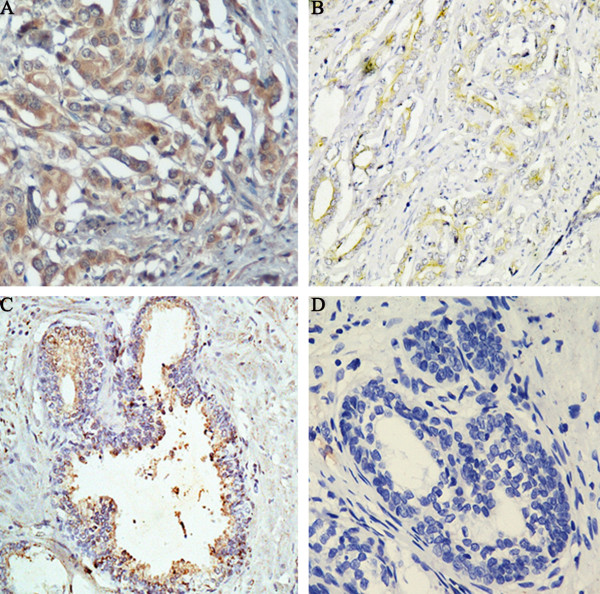
Immunohistochemical staining for NUCB2 in PCa and benign prostate tissue (original magnification ×200). (A) High NUCB2 protein expression was found in cytoplasm of PCa tissues. (B) Low NUCB2 protein expression was found in cytoplasm of PCa tissues. (C) NUCB2 weakly positive staining was found in cytoplasm of benign prostate tissue. (D) Negative immunostaining of negative controls with the primary antibody omitted in PCa tissues.